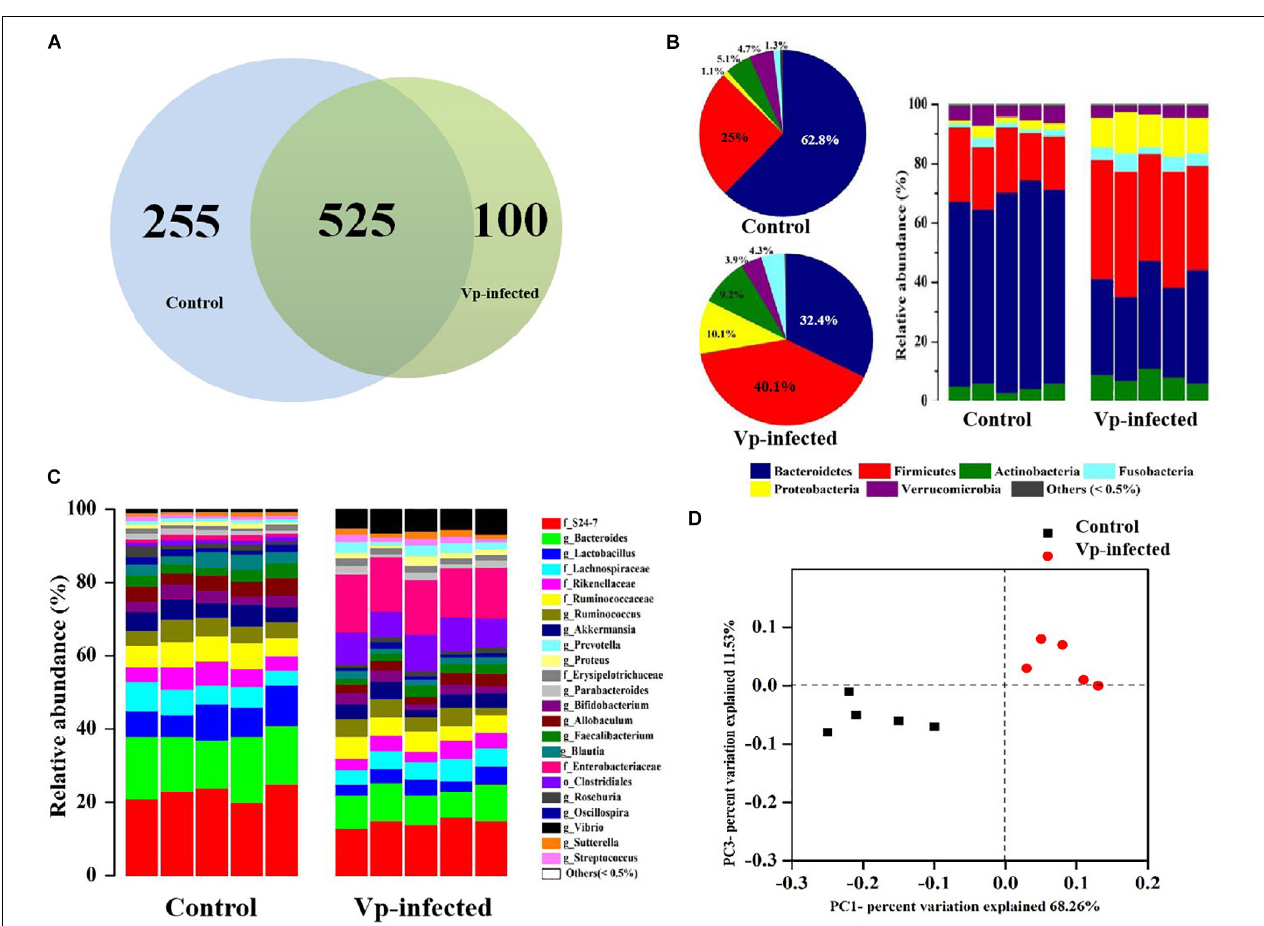
FIGURE 4 | Vibrio parahaemolyticus -induced gut microbiota dysbiosis. (A) Venn diagram analysis of unique/shared OTUs in the gut microbiota of experimental mice following V. parahaemolyticus (Vp) infection. (B,C) The ileum microbiome composition profiles at the phylum and genus level in the control group and Vp-infected groups (each color represents one bacterial taxon). (D) UniFrac principal co-ordinates analysis estimates of ileum microbiota in the control and Vp-infected